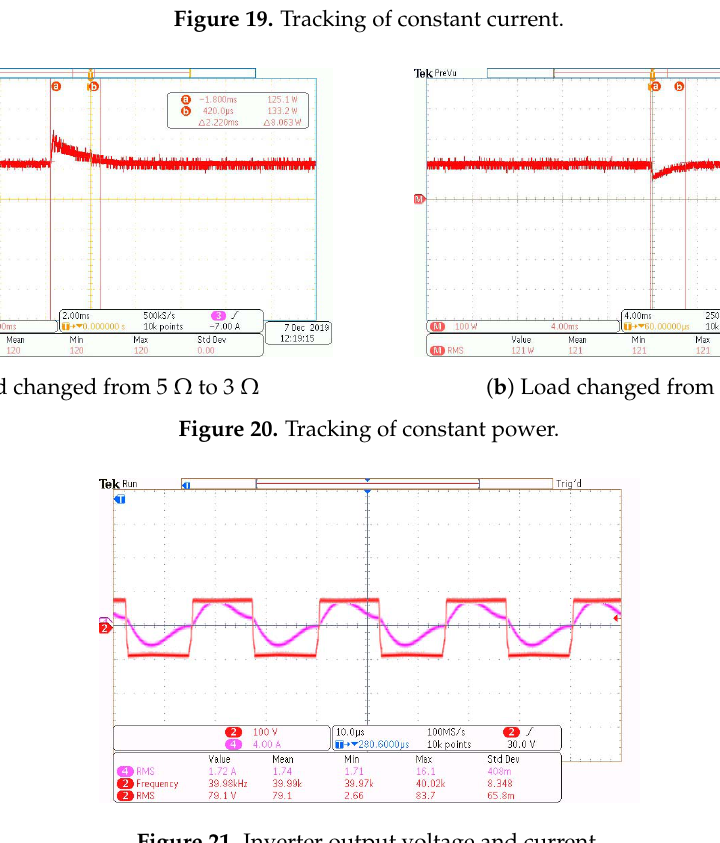
Figure 21. Inverter output voltage and